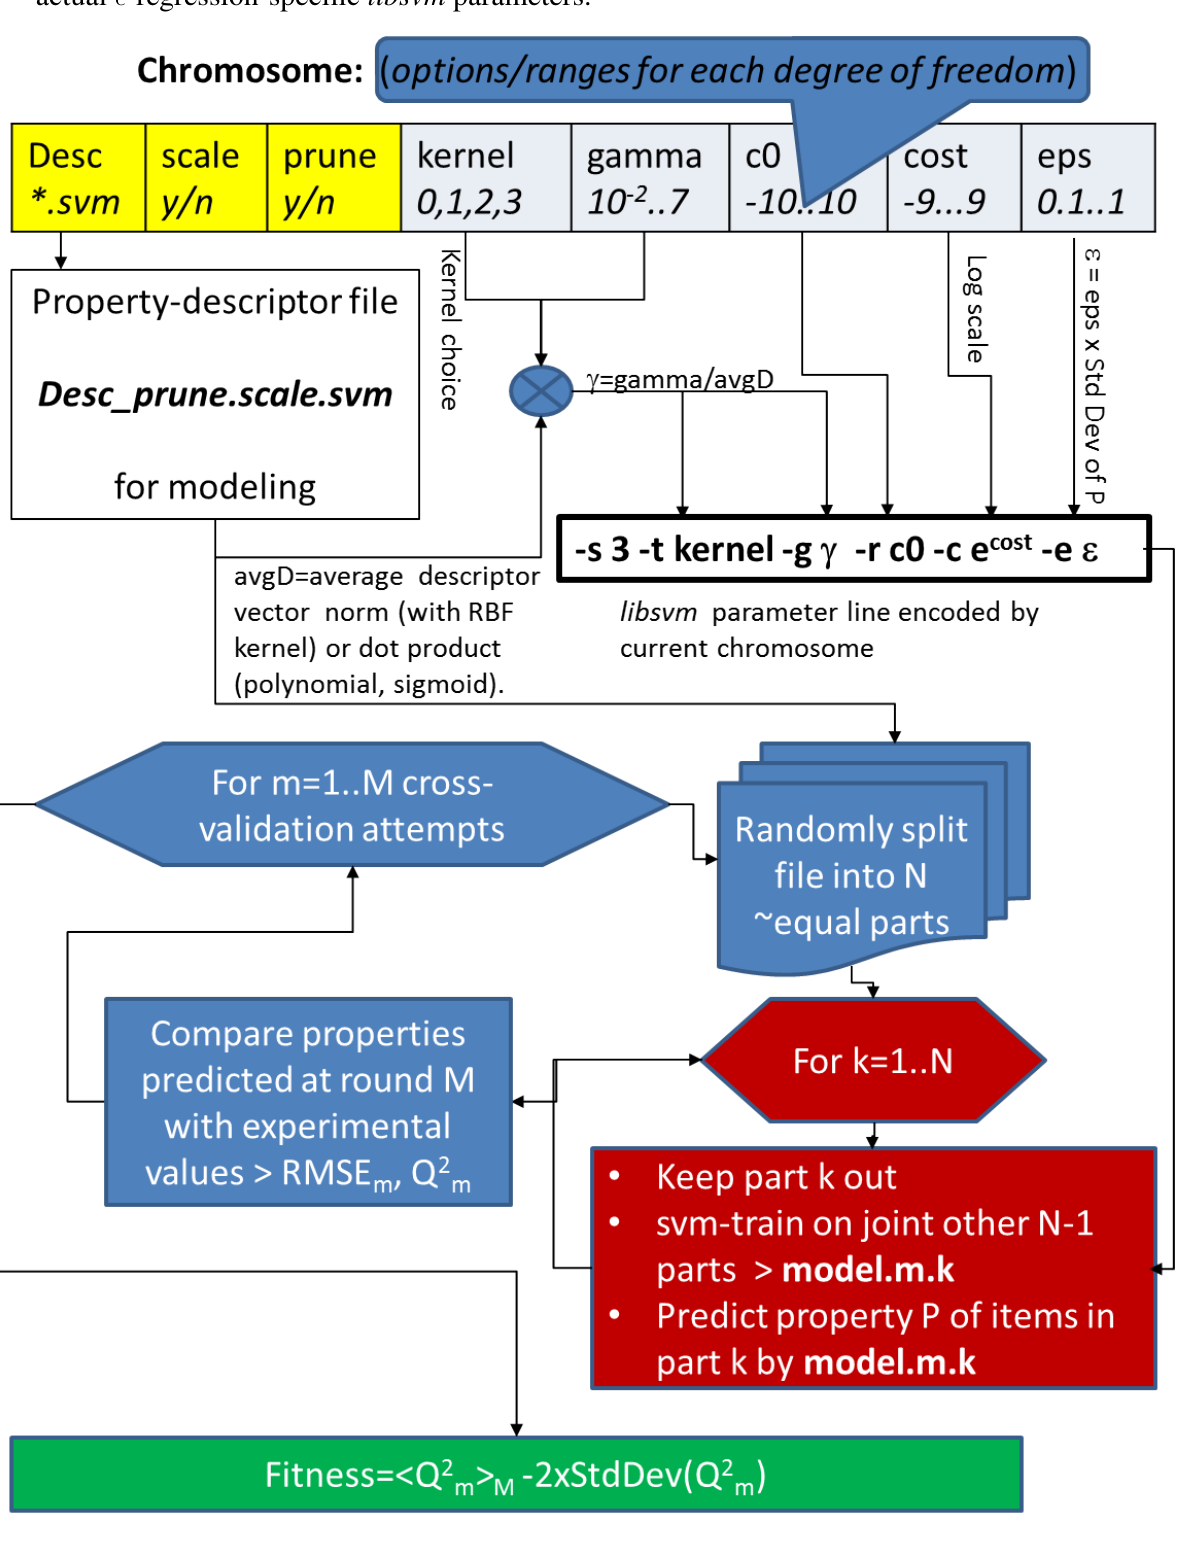
Figure 1. Workflow of fitness estimation of a SVR chromosome encoding both the choice of descriptor/attribute set and its optional preprocessing requirements (scaling, pruning) and actual (cid:15) -regression-specific libsvm